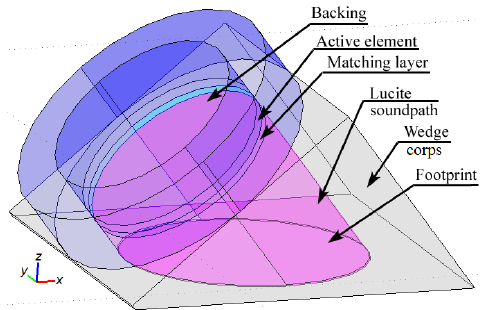
Figure 5. The geometry of wedge actuator’s finite-element (FE) model [41].